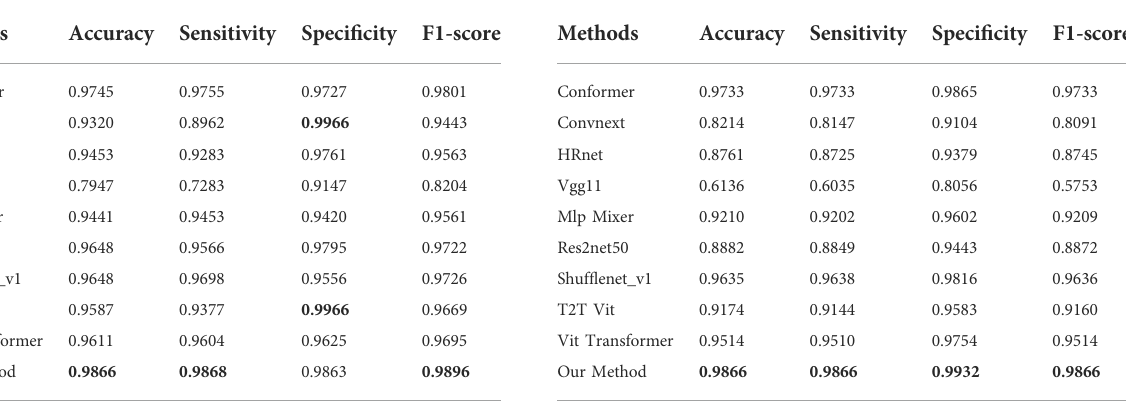
TABLE 4 Comparing the existing methods of multi-classi fi cation for macular